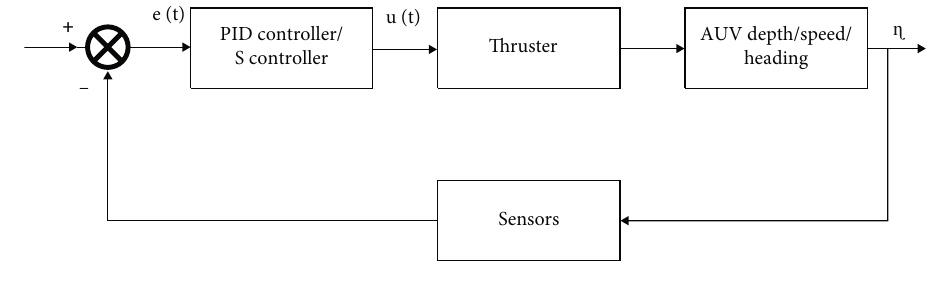
Figure 15: The control